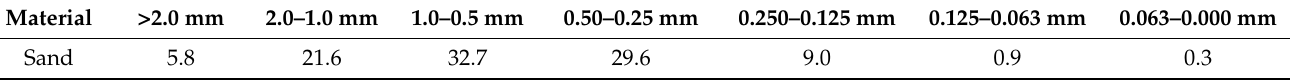
Table 2. Grain-size distribution of sand (%).